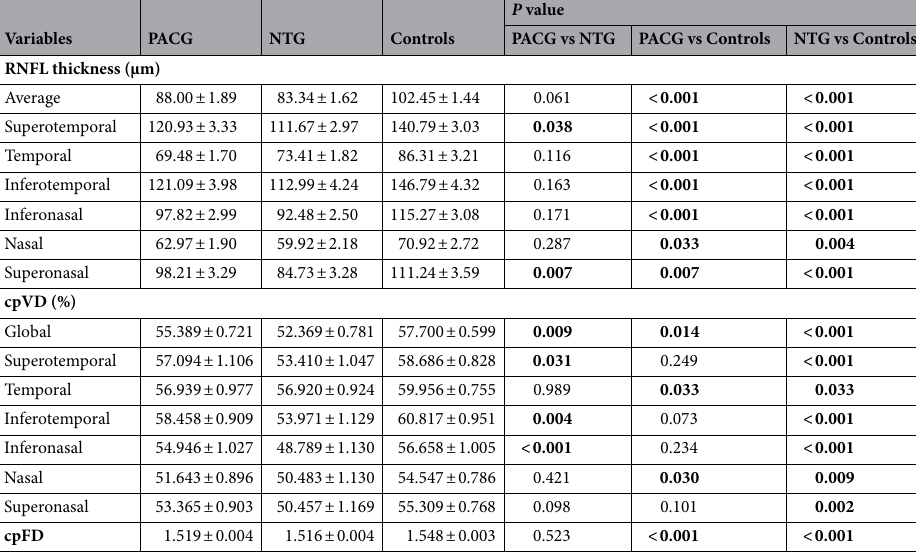
Table 2. Comparison of RNFL thickness and OCT-A metrics among PACG, NTG, and Controls. Significant values are in bold. Statistical significance was tested by generalized estimating equation with Sequential Bonferroni post-hoc test. cpRNFL = circumpapillary retinal nerve fiber layer; cpVD = circumpapillary vessel density; cpFD = circumpapillary fractal dimension; PACG = primary angle closure glaucoma; NTG = normal tension glaucoma.